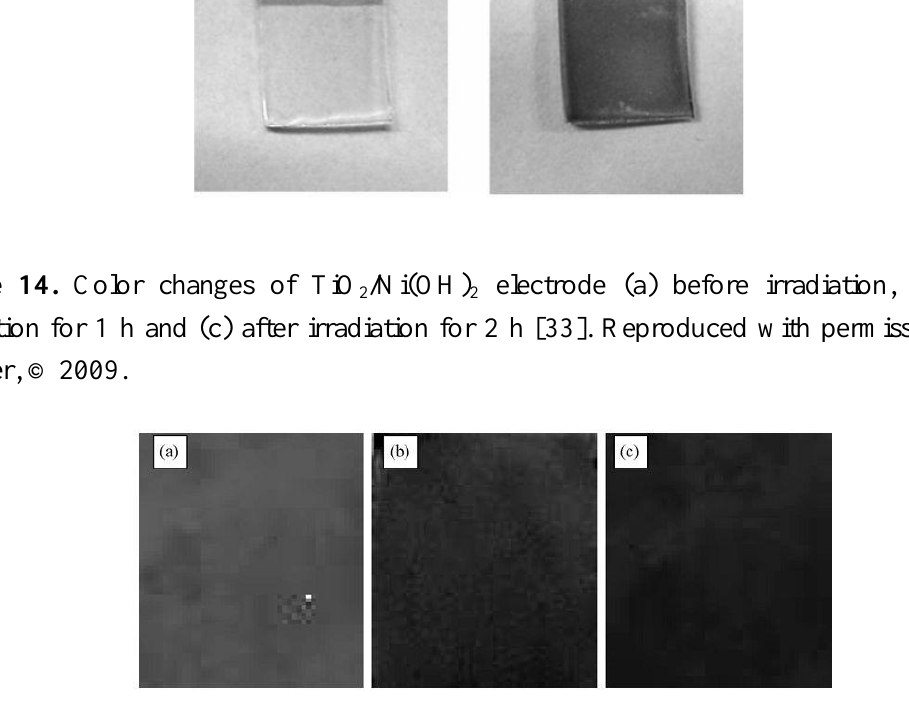
Figure 13. TiO /Ni(OH) film before (a) and after (b) UV irradiation for 2 h in 2 2 NaHCO /NaOH buffer (pH 10) [26]. Reproduced with permission from the ACS, ©2005. 3